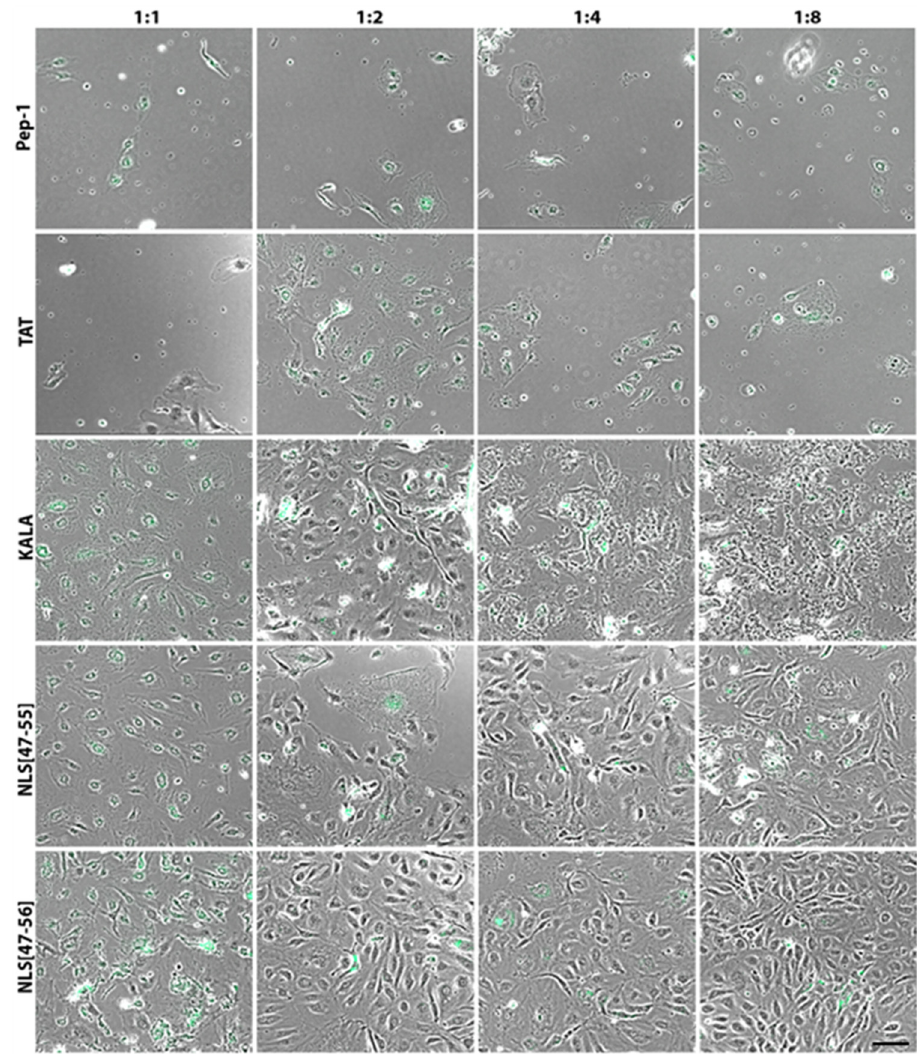
Figure 11. Effect of 24 h culture in the presence of complexes in CRs of 1:1, 1:2, 1:4 and 1:8. The complexes were formed using incubation of 2 μ g pmaxGFP with chosen CPPs at 21 °C for 30 min. CR, charge ratio. (A) Transfection efficiency. (B) Percent of cells with abnormal morphology. Data are presented as means, numbers in parentheses represent standard deviations.